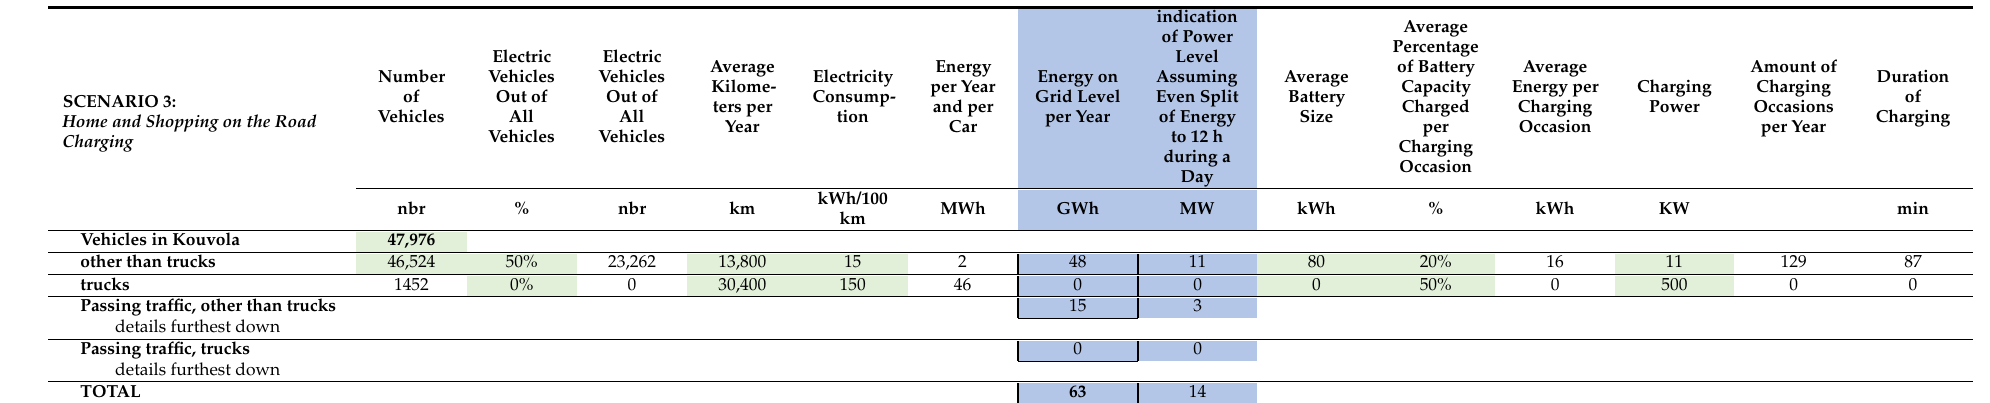
Table A7. Summary of Kouvola-based and passing traffic (including detailed quantification of the Kouvola-based traffic). Blue cells indicate results and green input